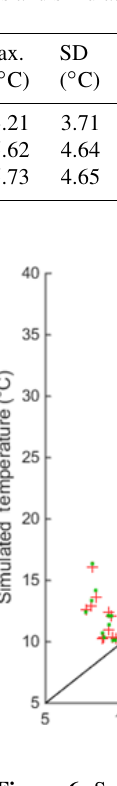
Table 4. The 2m temperature statistical measures from collocated stations and simulation outputs.